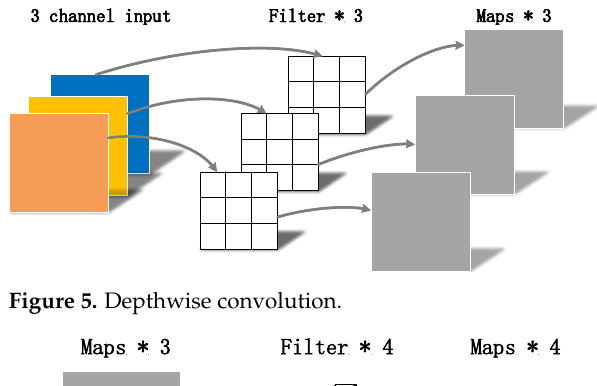
Figure 4. Standard convolution.